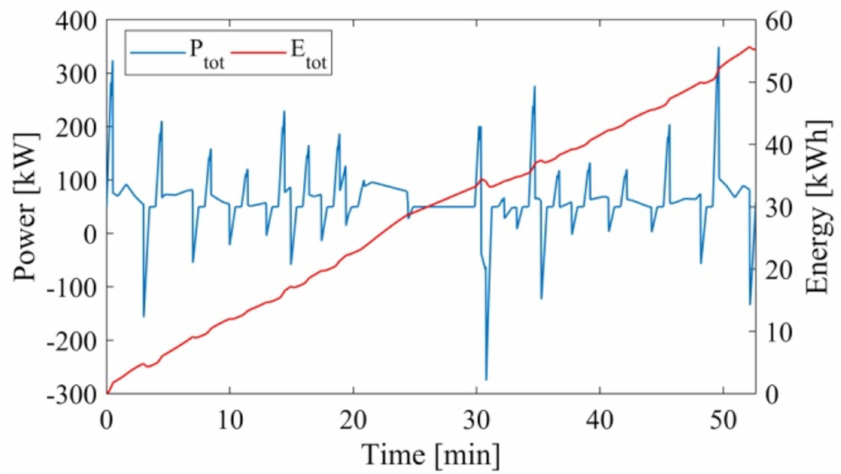
Figure 2. Power and energy demand.